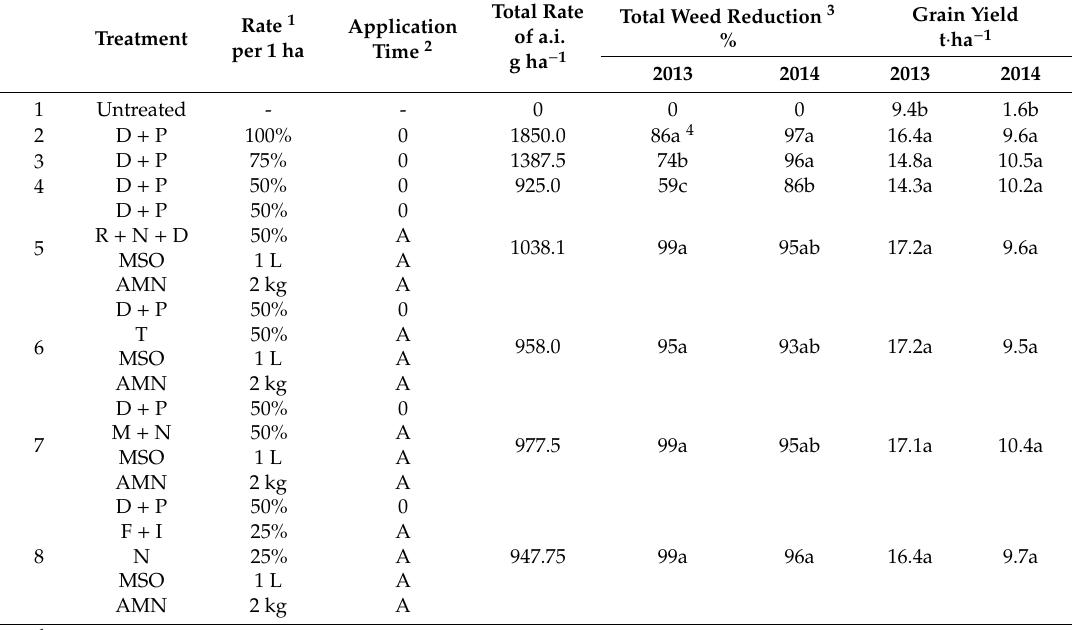
Table 4. Influence of herbicides on weed control and grain yield.